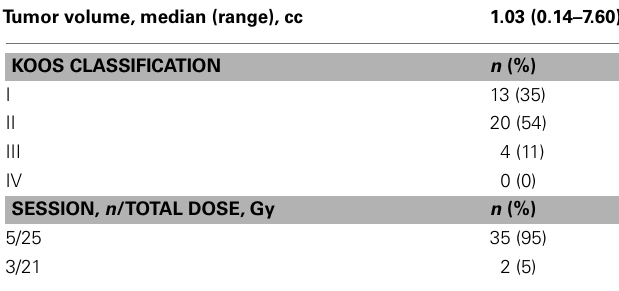
Table 2 |Treatment